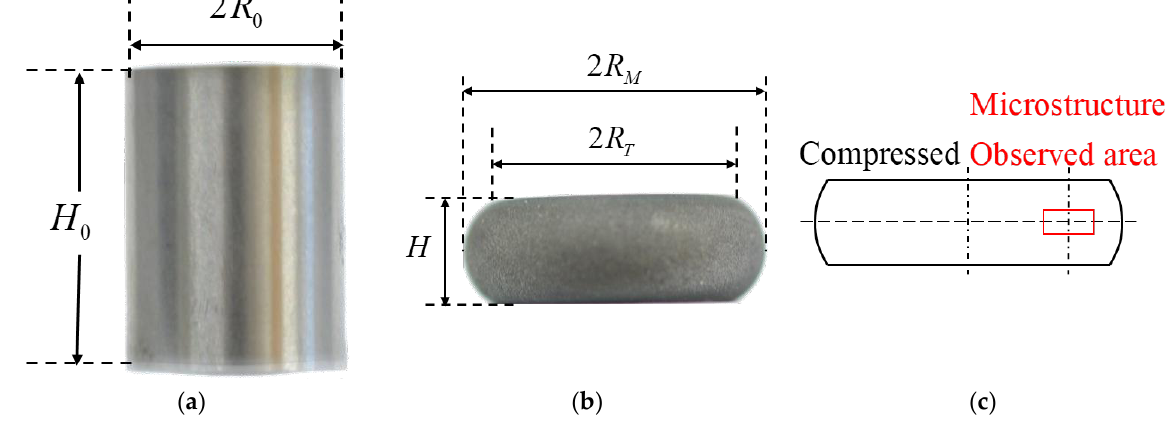
Figure 1. Compression test specimen: ( a ) before deformation, ( b ) after deformation, ( c ) the area for microstructure observation.